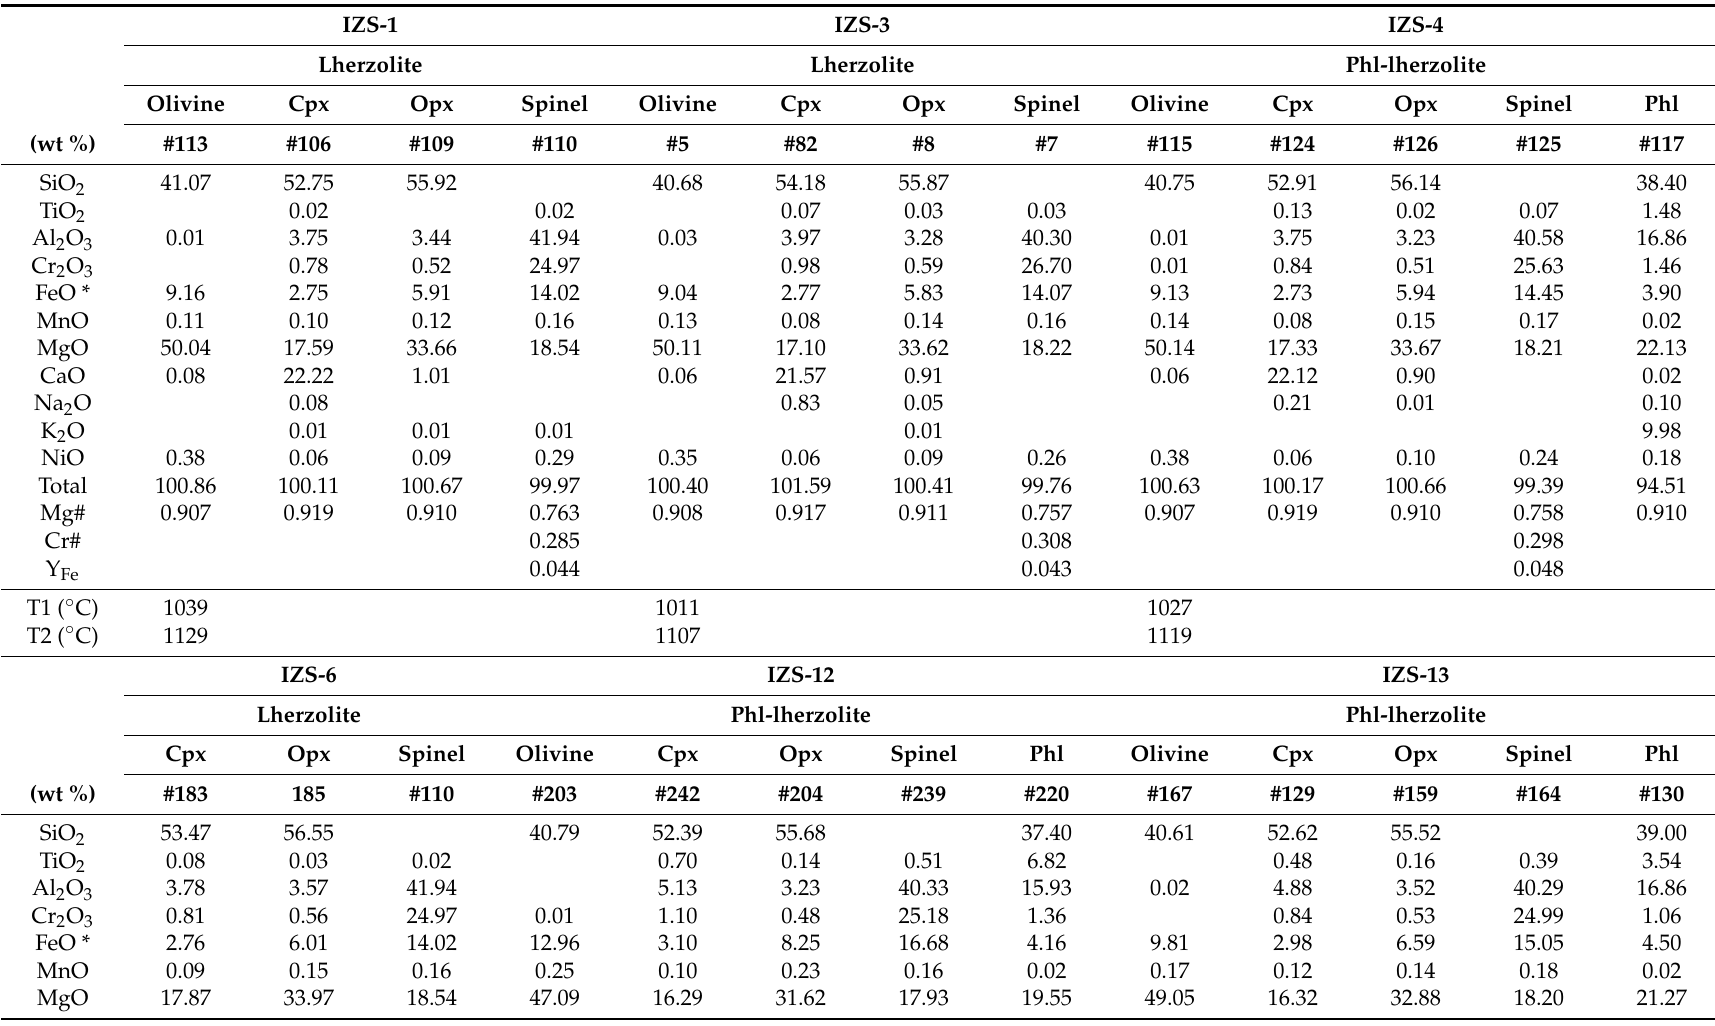
Table 2. Representative major-element compositions of minerals in peridotite xenoliths from Bankawa, the SW Japan